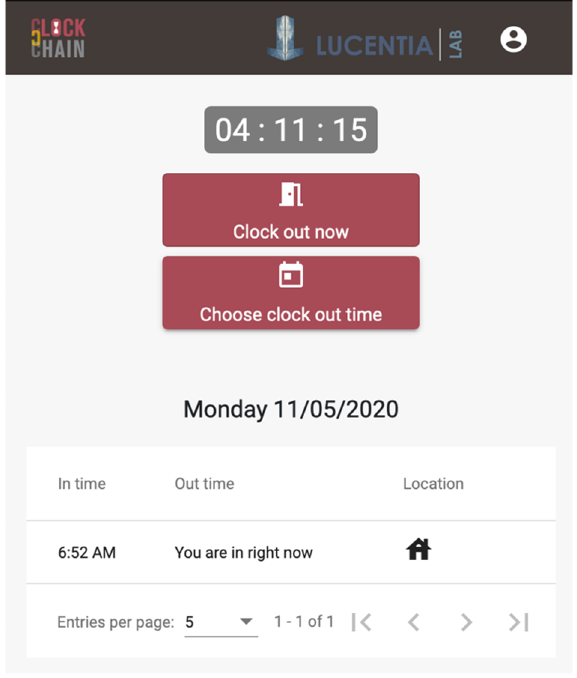
Figure 4. Clockchain interface for a user when clocking out.